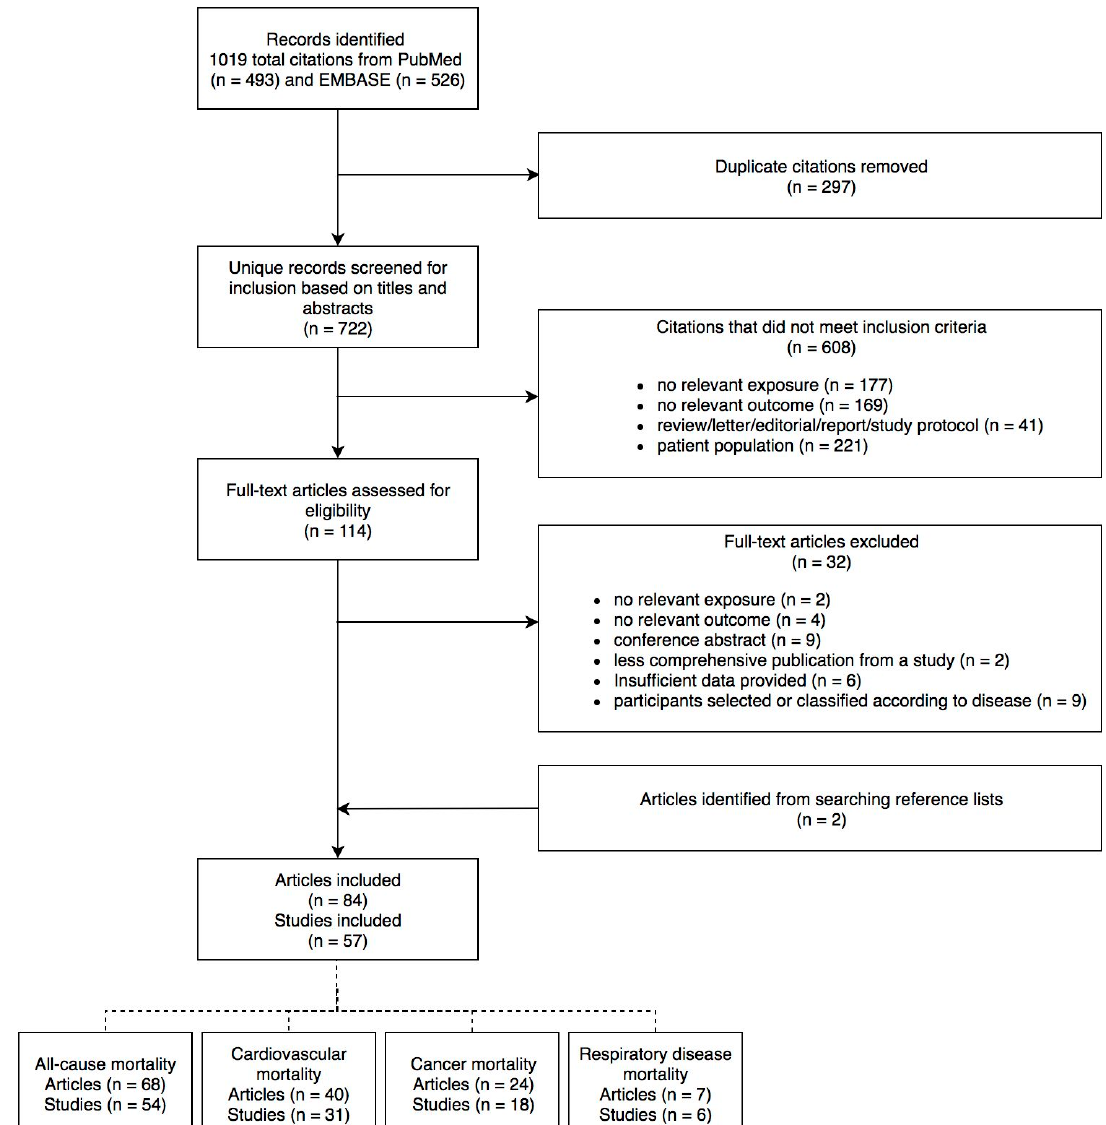
Figure 1. Flow diagram of selection of studies included in the review. 127